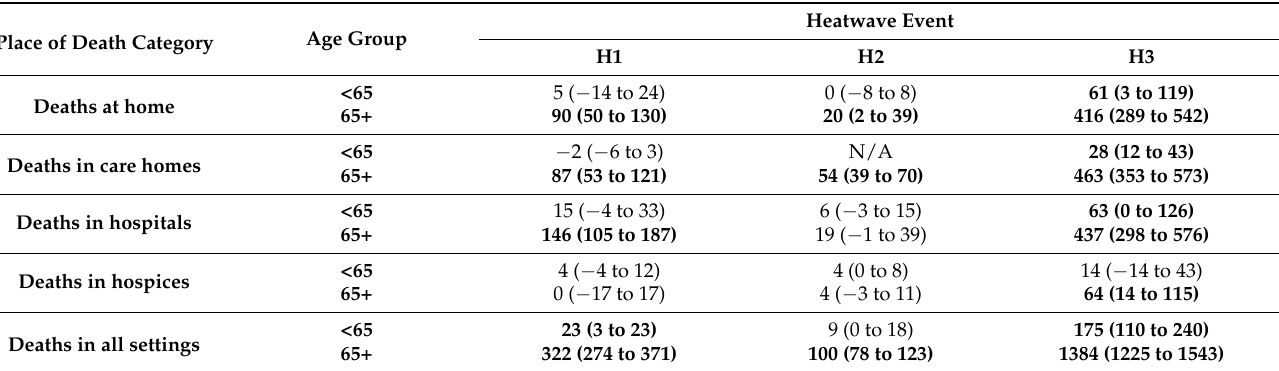
Table 2. Estimated excess all-cause mortality by age group and place of death in affected regions during heatwaves in England, summer 2020. Bold values indicate all-cause excess mortality esti- mates considered to be statistically significant (above 3SD), with values within the brackets the 95% Confidence intervals. Heatwave1 (H1) occurred 23 to 27 June affecting EM, WM, EoE, LON, SE, and SW; Heatwave2 (H2) occurred 30 July to 1 August. All regions affected; Heatwave3 (H3) occurred 5 to 15 August affecting EoE, LON, and SE.